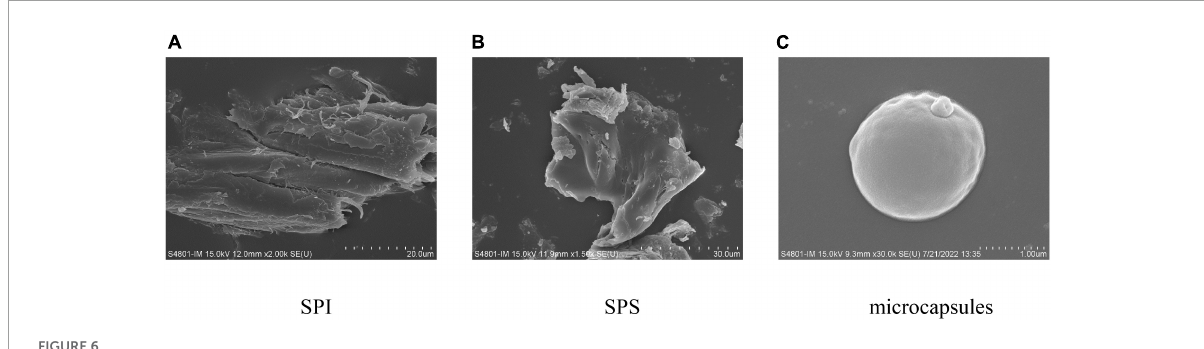
FIGURE6 Scanning electron micrograph of panel (A) SPI, (B) SPS, (C)